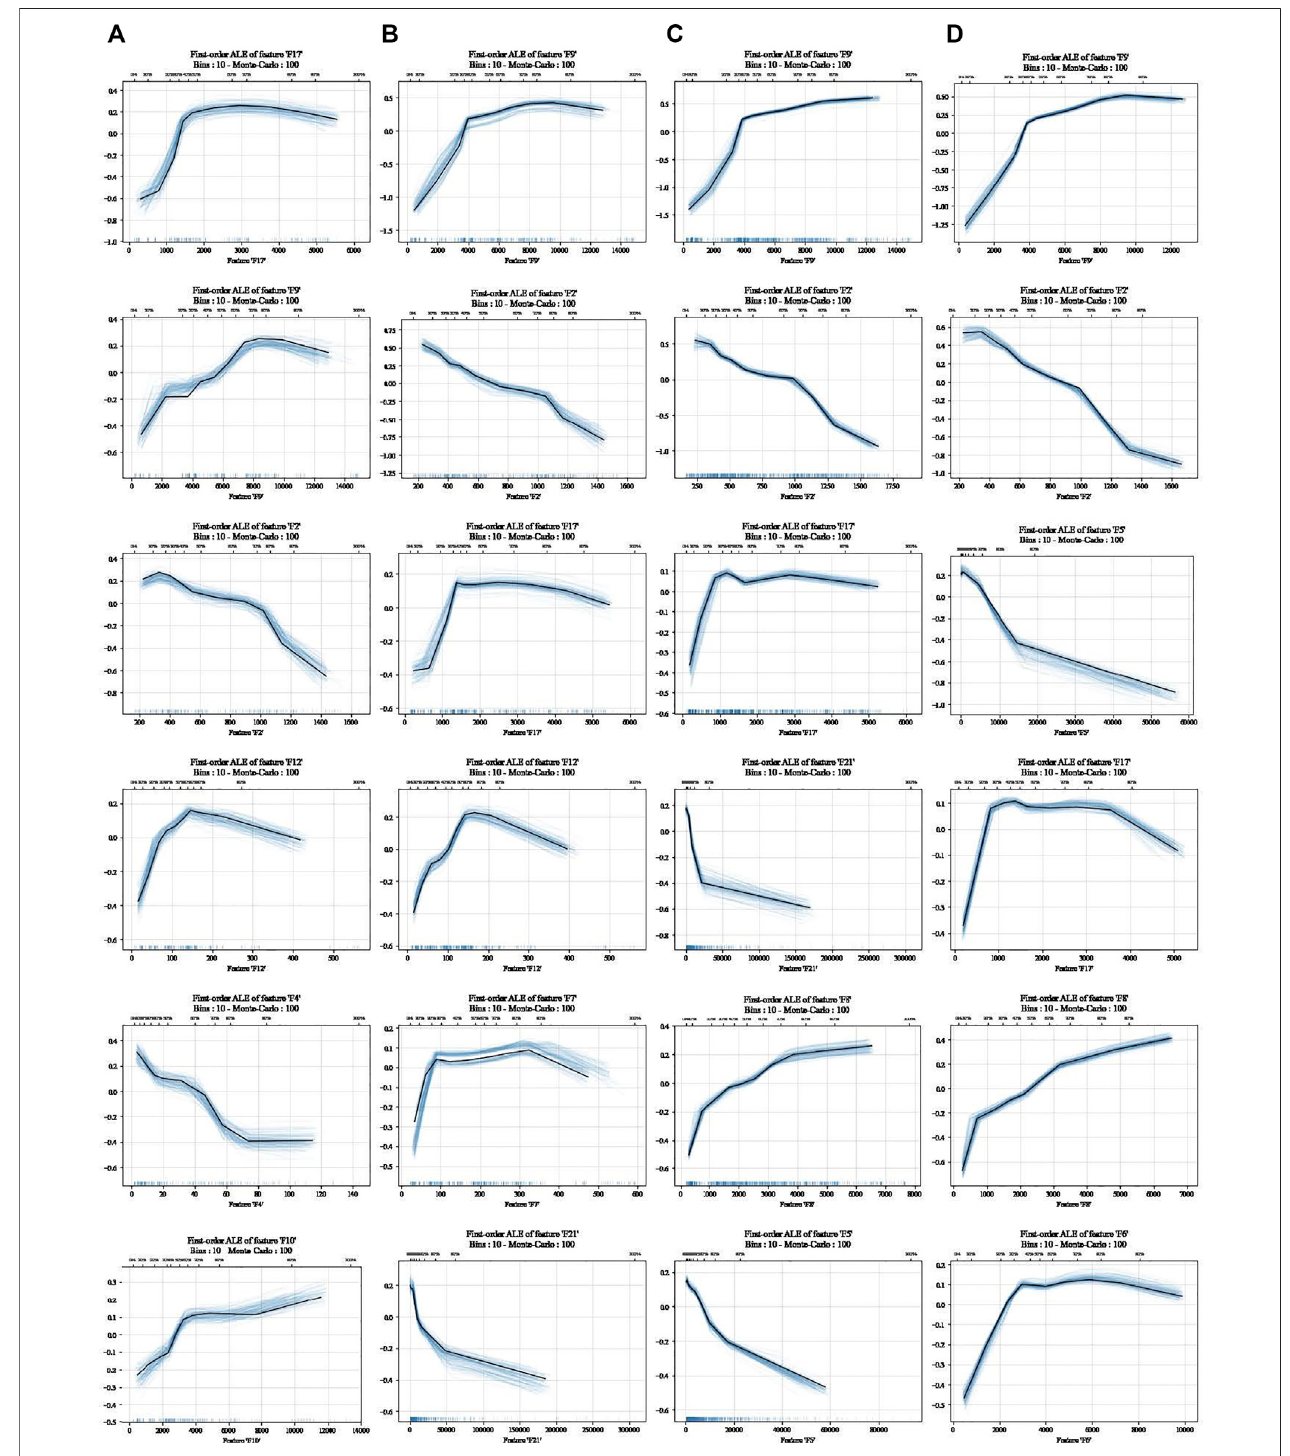
FIGURE 9 | ALE plots of top six features controlling drought-affected area. (A) 2011 – 2019. (B) 2004 – 2019. (C) 1987 – 2019. (D) 1979 – 2019.